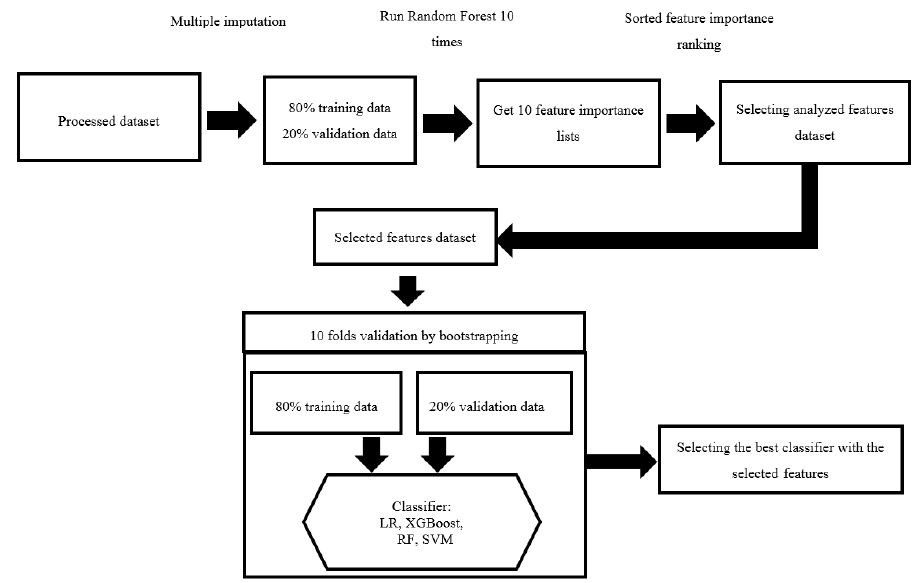
Figure 2. The process of feature selection and the application of machine learning algorithms.